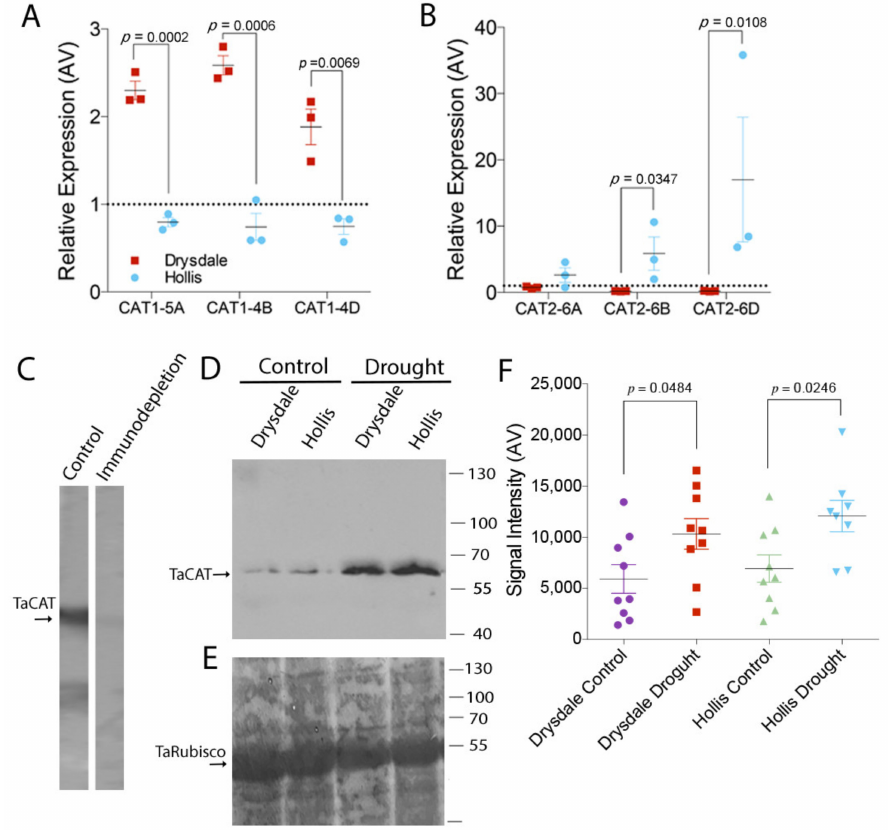
Figure 7. Characterization of Catalase in response to drought stress. ( A ) Transcription of CAT1 homoeologs in leaves of control and drought-stressed Hollis and Drysdale plants. p -values were calculated using Student t -test ( n = 3). ( B ) Transcription of CAT2 homoeologs in leaves of control and drought-stressed Hollis and Drysdale plants. p -values were calculated using Student t -test ( n = 3). Values above the dashed line indicate up-regulation; values below the line indicate down-regulation. ( C ) Western blotting with anti-CAT or following immunodepletion of the antibody with the CAT pro- tein. Pre-incubation of the antibody with catalase abrogates recognition of catalase on the membrane with total protein extract from the leaf of Drysdale plants. ( D ) Western blotting of total protein extracts from leaves of control and drought-stressed Drysdale and Hollis plants. Bars and numbers indicate the position and corresponding size of molecular weight markers. ( E ) Colloidal silver staining of the Western blotting membrane showing total protein in the corresponding extracts. Bars and numbers indicate the position and corresponding size of molecular weight markers. ( F ) Quantification of CAT protein levels on the Western blotting membranes. p -values represent Student t -test results of three technical replicates of extracts from three biological replicates (individual